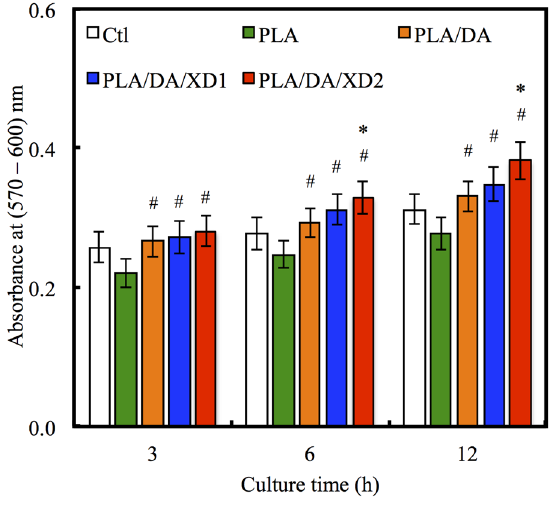
Figure 5. The adhesion of hBMSCs cultured with various specimens for different time points. The values shown are means ± standard errors for all the assays. “#” indicates a significant difference ( p < 0.05) compared to PLA; “*” indicates a significant difference ( p < 0.05) compared to